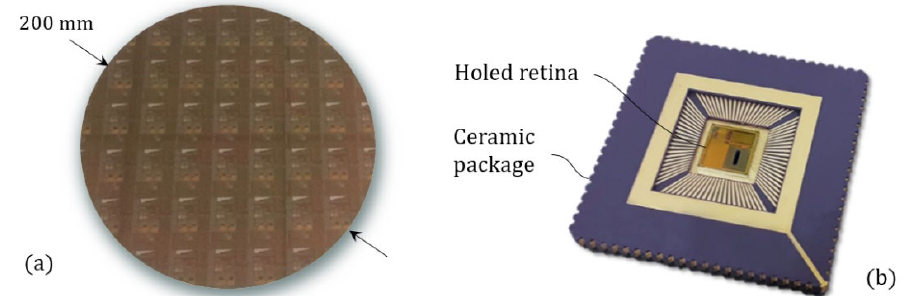
Figure 1. ( a ) Photography of a 200 mm wafer that contains the custom image sensors. ( b ) Photography of a holed retina bonded on the ceramic carrier.